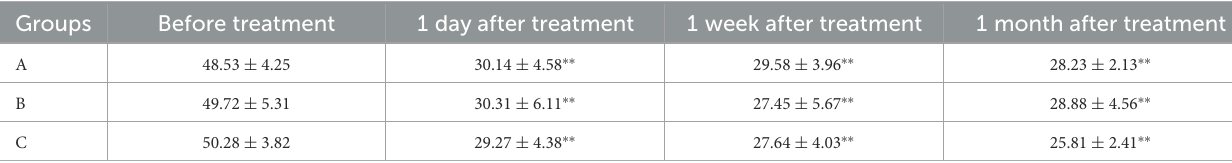
TABLE 5 SDS scores of patients before and after treatment (mean ±